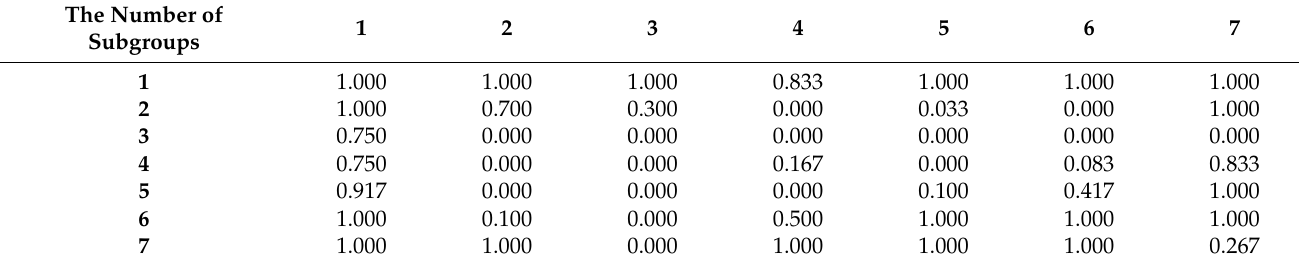
Table 3. Cohesive subgroup density matrix in